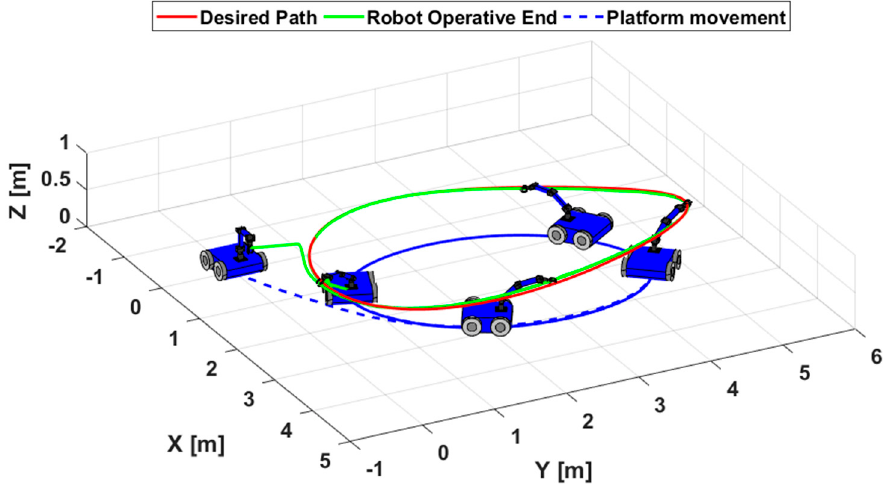
Figure 13. Strobe movement in the space of the robotic system for the first experiment considering ROC analysis.